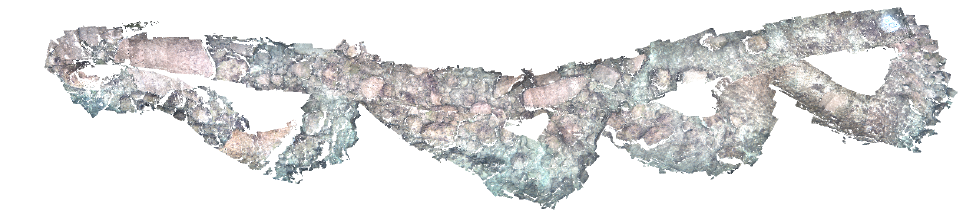
Figure 11. 3D reconstruction from SV using graph SLAM (25 × 10 m, Mallorca)